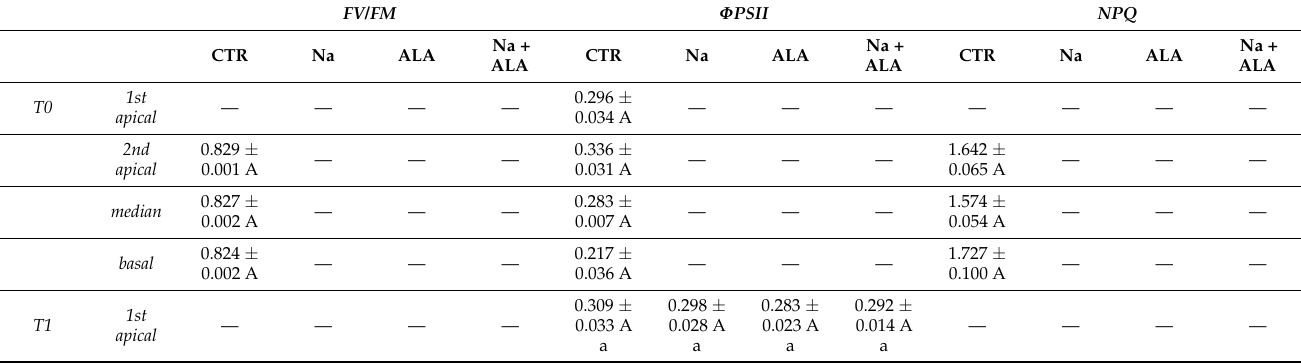
Table 2. Maximum quantum efficiency of photosystem II (F V /F M ), photosystem II quantum yield ( Φ PSII), and non-photochemical quenching (NPQ) measured at different time points (T0, T1, T2, and R) in apical, median, and basal leaves along the profile of Arundo donax controls (CTR), salt- stressed (Na), ALA-treated ALA (ALA), and both salt-stressed and ALA-treated (Na + ALA) plants. Mean values ± SE are shown. At any time-point, uppercase letters indicate statistically significant differences between (apical, median, and basal) leaves of plants undergoing the same treatment, and lowercase letters indicate statistically significant differences between (apical, median, and basal) leaves of plants undergoing different treatments ( p < 0.05; n = 3). FV/FM Φ PSII NPQ CTR Na ALA Na + ALA CTR Na ALA Na + ALA CTR Na ALA Na + ALA